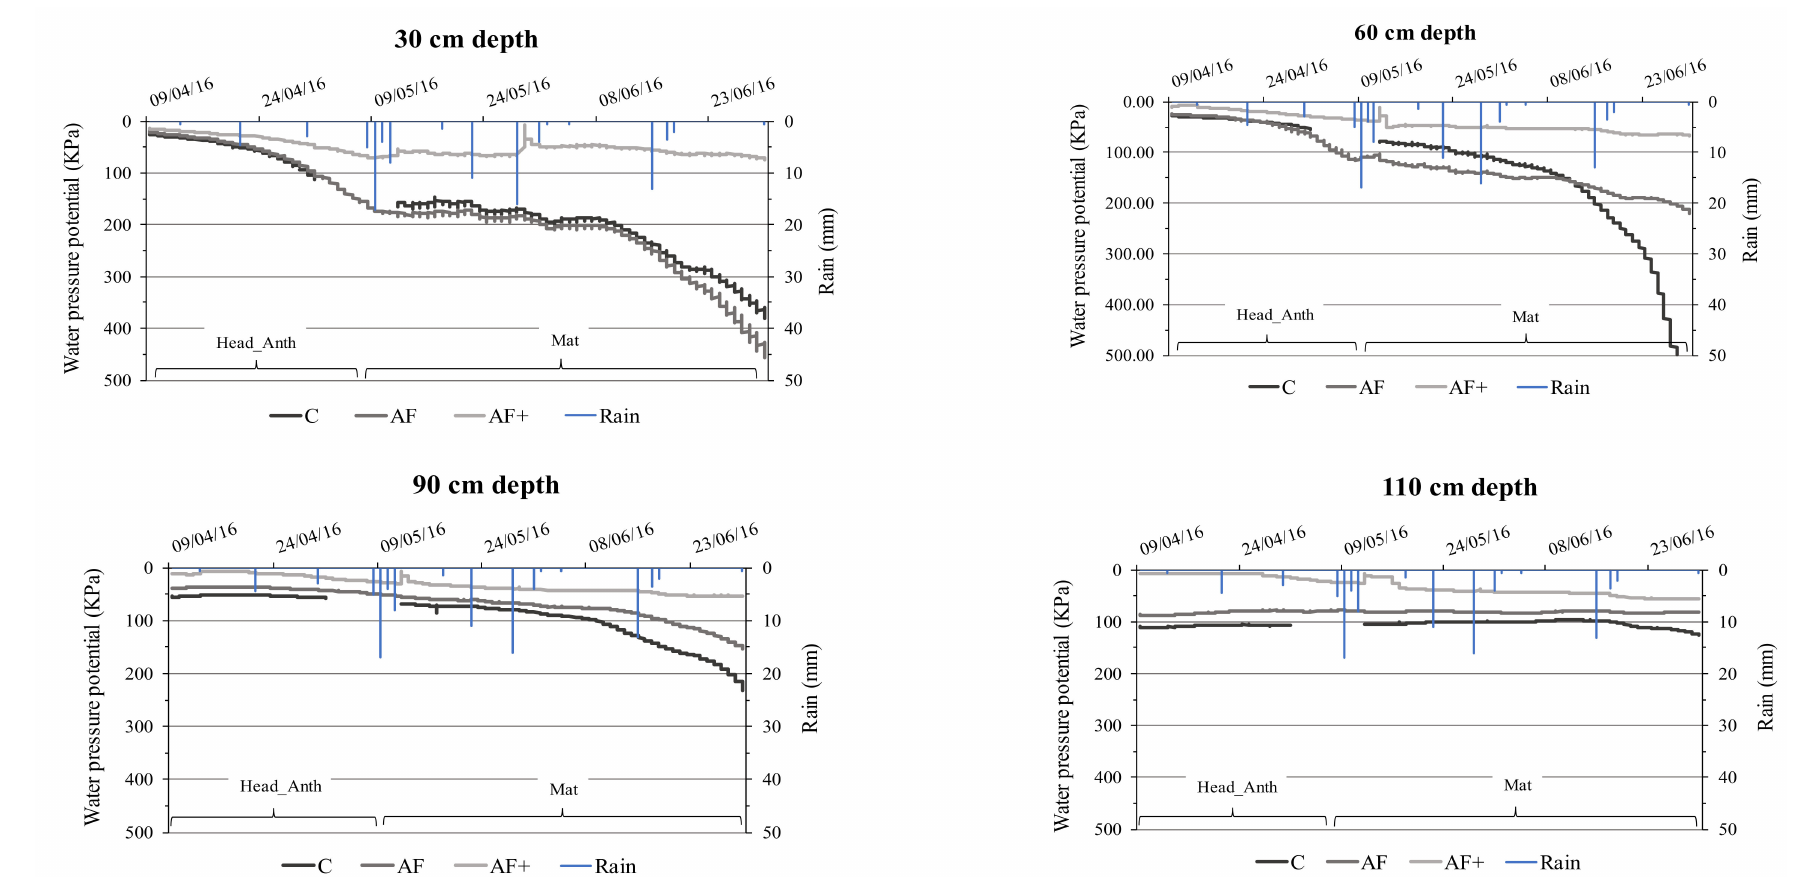
Figure 4. Soil water potential as hourly average pressure potential (KPa) recorded by tensiometers placed in the three treatments (C, AF and AF+) at four soil depths, i.e., 30 ( top-left ), 60 ( top-right ), 90 ( bottom-left ) and 110 ( bottom-right ) cm, during the 1st year (2015–16) wheat growing season. Timeline in the x axis is divided into three periods: stem elongation (Stem elong) (from sowing to 7 April; data not available in 2015–16), heading and anthesis (Head_Anth) (from 8 April to 10 May) and maturity (Mat) (from 11 May to harvesting). The secondary vertical axis indicates daily rainfall (mm) within the same